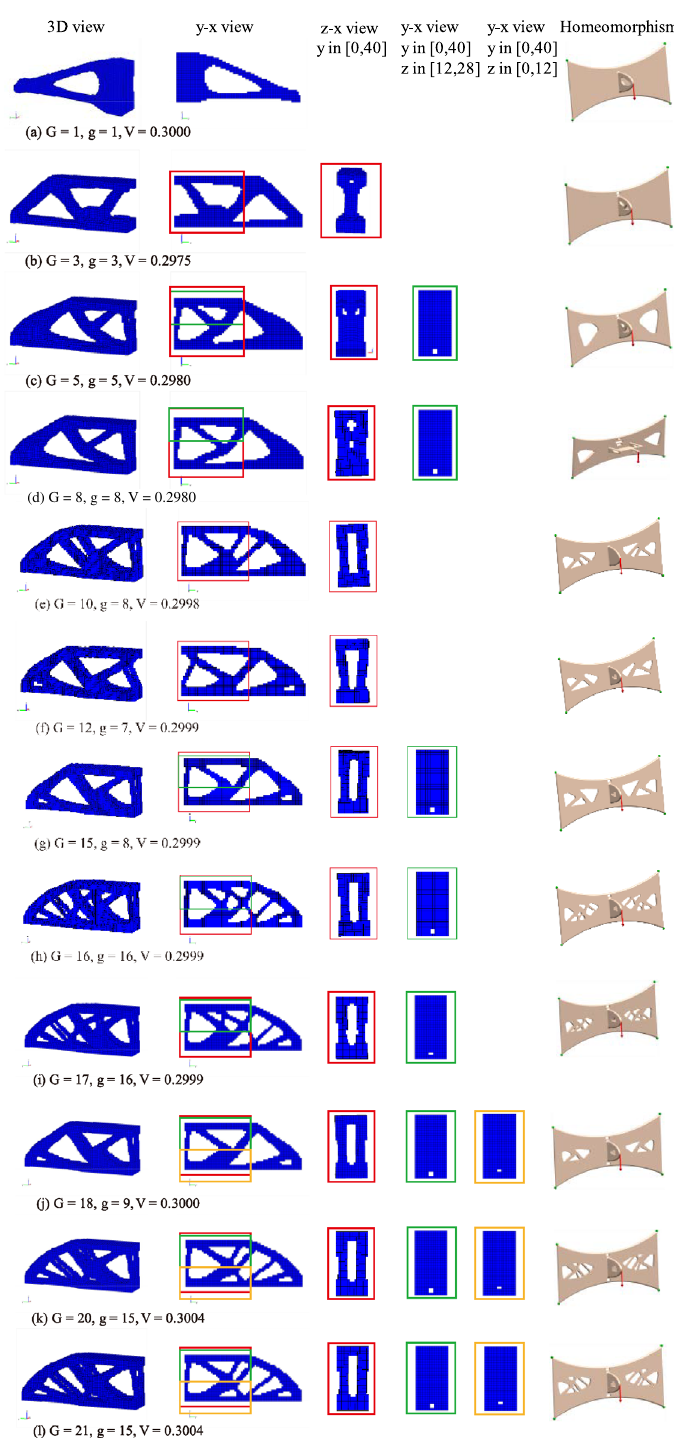
Figure 8. Topology constraint results of 3D cantilever beam topology optimization. G is the upper limit of the genus, and g is the actual genus of the final structure. In the homeomorphism graph, the green dots represent displacement constraints, and the red arrow represents a